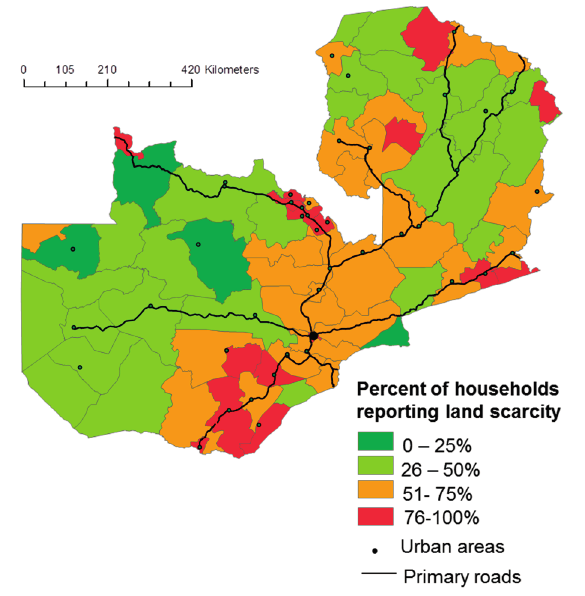
Figure 5. Percent of small and medium-scale farmers reporting that land local traditional authorities no longer have land to allocate to resident. Source: RALS 2012.